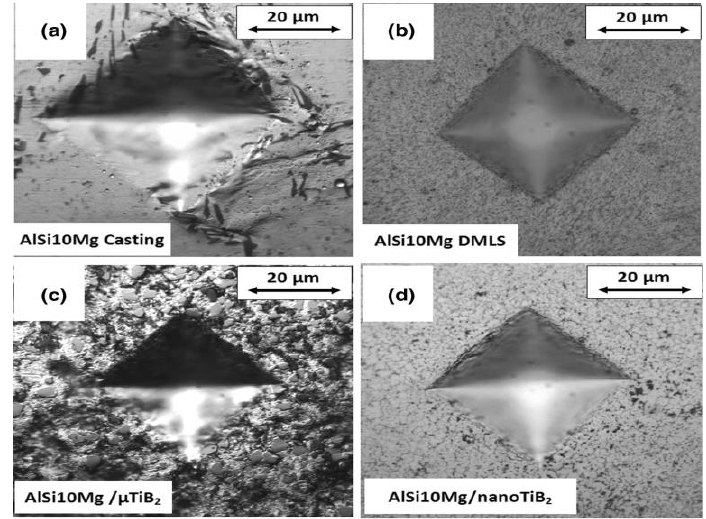
Figure 14. The microhardness indentations on AlSi10Mg samples obtained by casting ( a ) and DMLS ( b ), and of the composites with micro- ( c ) and nano TiB2 particles ( d ). Reproduced from [43], with permission from Springer Nature, 2016.